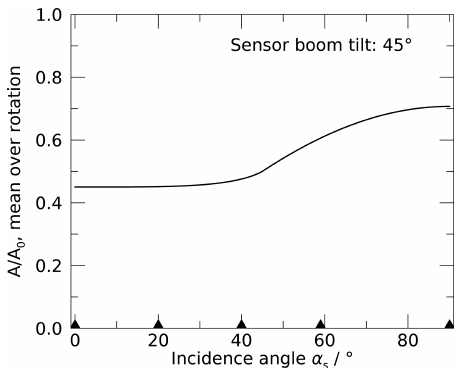
Figure 9. Relative exposed sensor boom surface area, averaged over rotation around the vertical, as function of light incidence (solar- elevation angle, α s ), and for the 45 ◦ boom angle of the RS41 ra- diosonde. The triangles mark the angles of incidence in the experi-